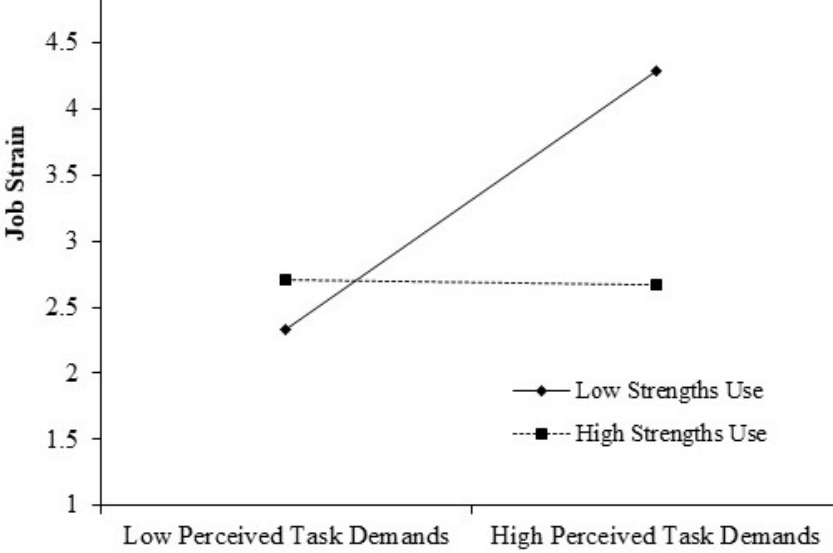
Figure 3. Results of the moderating effect of psychological entitlement.